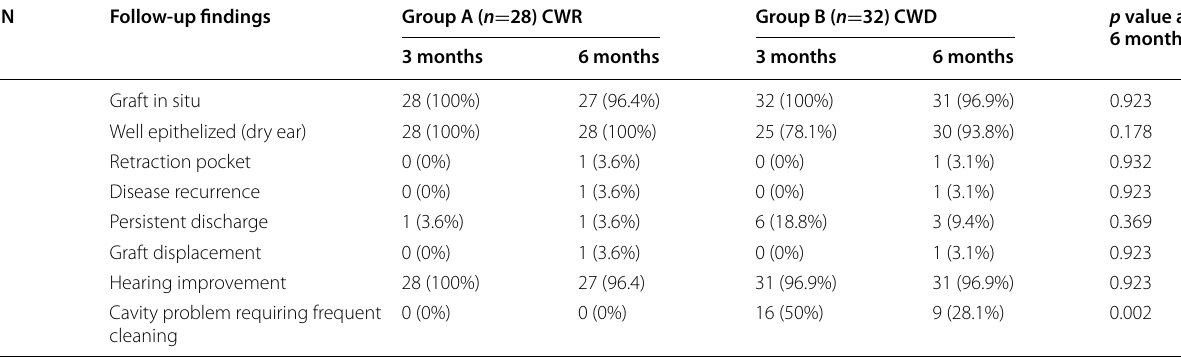
Table 5 Clinical findings of patients during follow-up at 3 months and 6 months comparing Group A and Group B